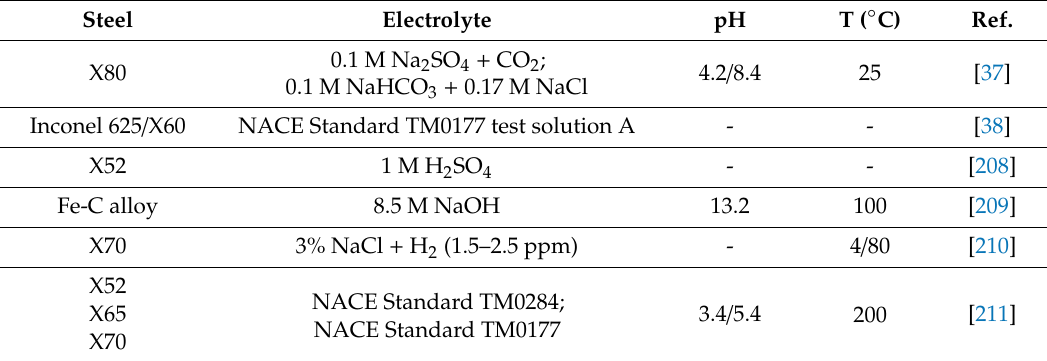
Table 8. Reviewed physicochemical properties for internal corrosion